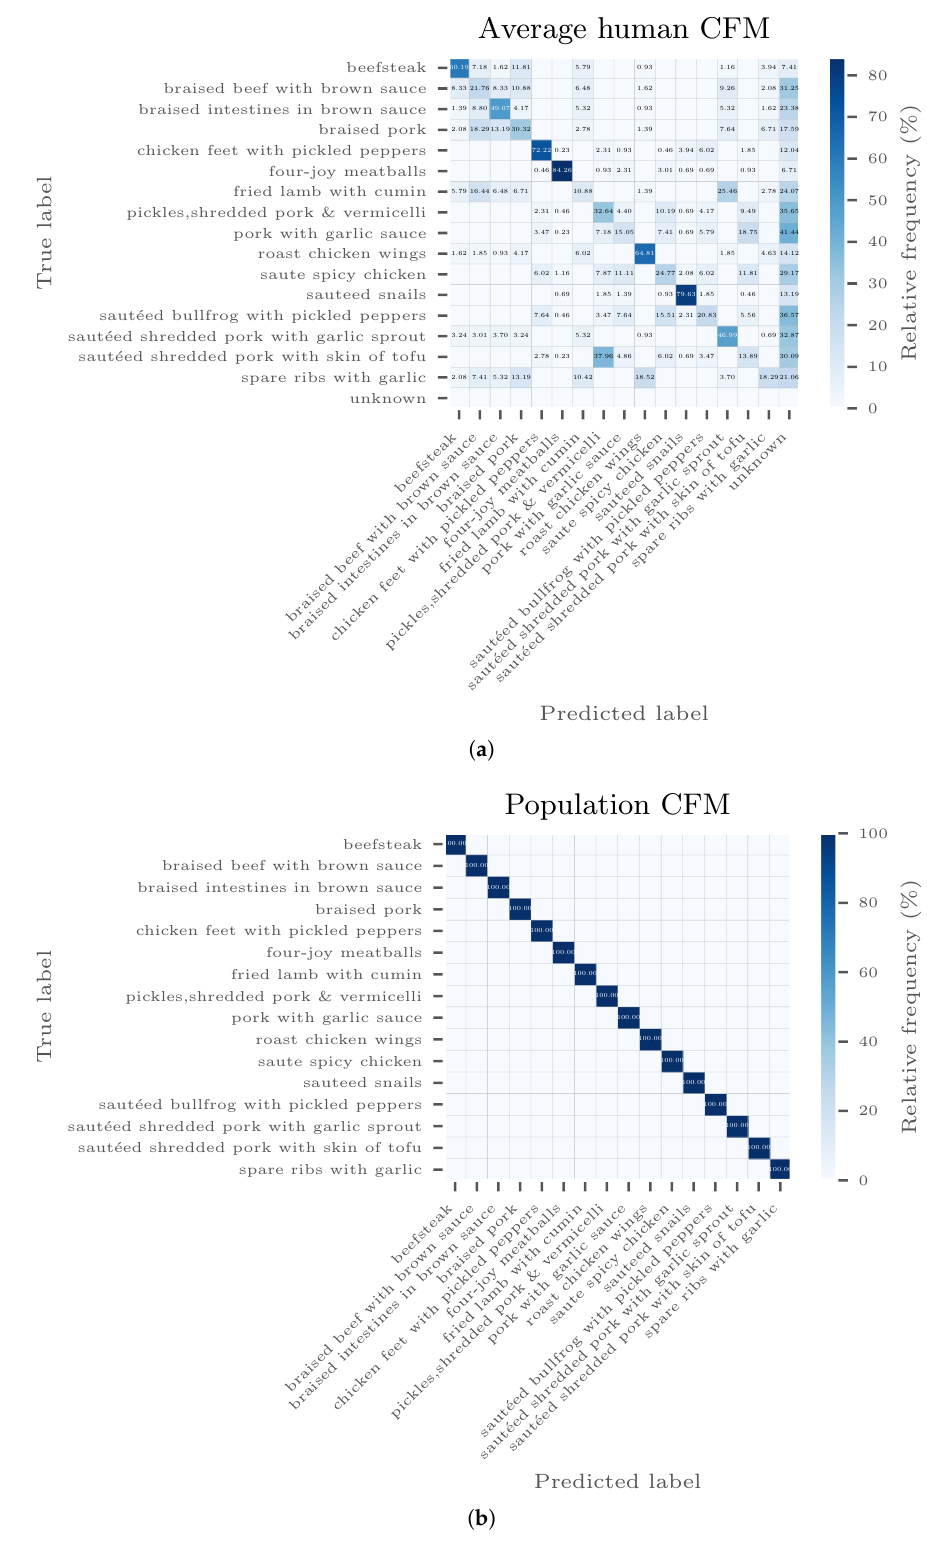
Figure A5. Average human ( a ) and population ( b ) CFMs for the ENG population of the VireoFood-172